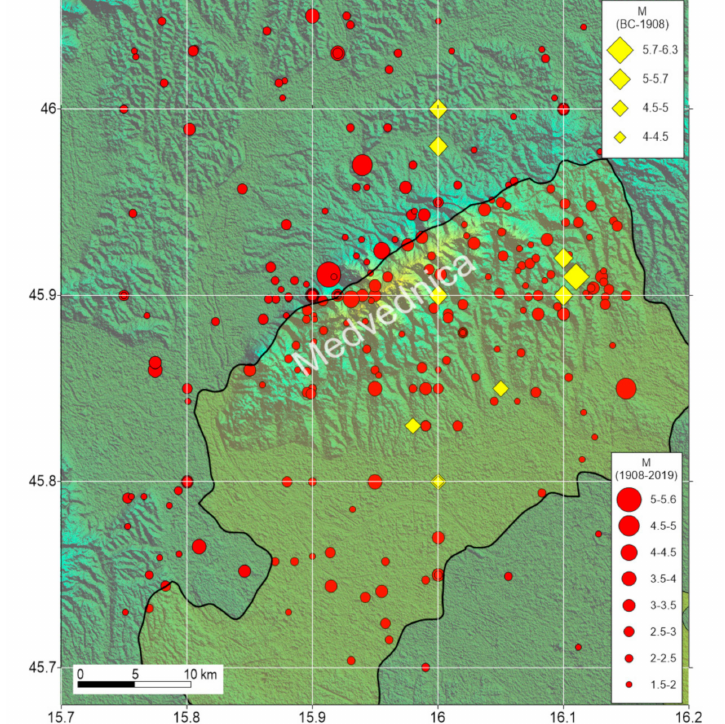
Figure 2. Spatial distribution of earthquakes with locations in the wider Zagreb area from BC to 2019 (according to the updated version of the Croatian Earthquake Catalogue, first described in [18]). The urbanized Zagreb city area is displayed with yellow